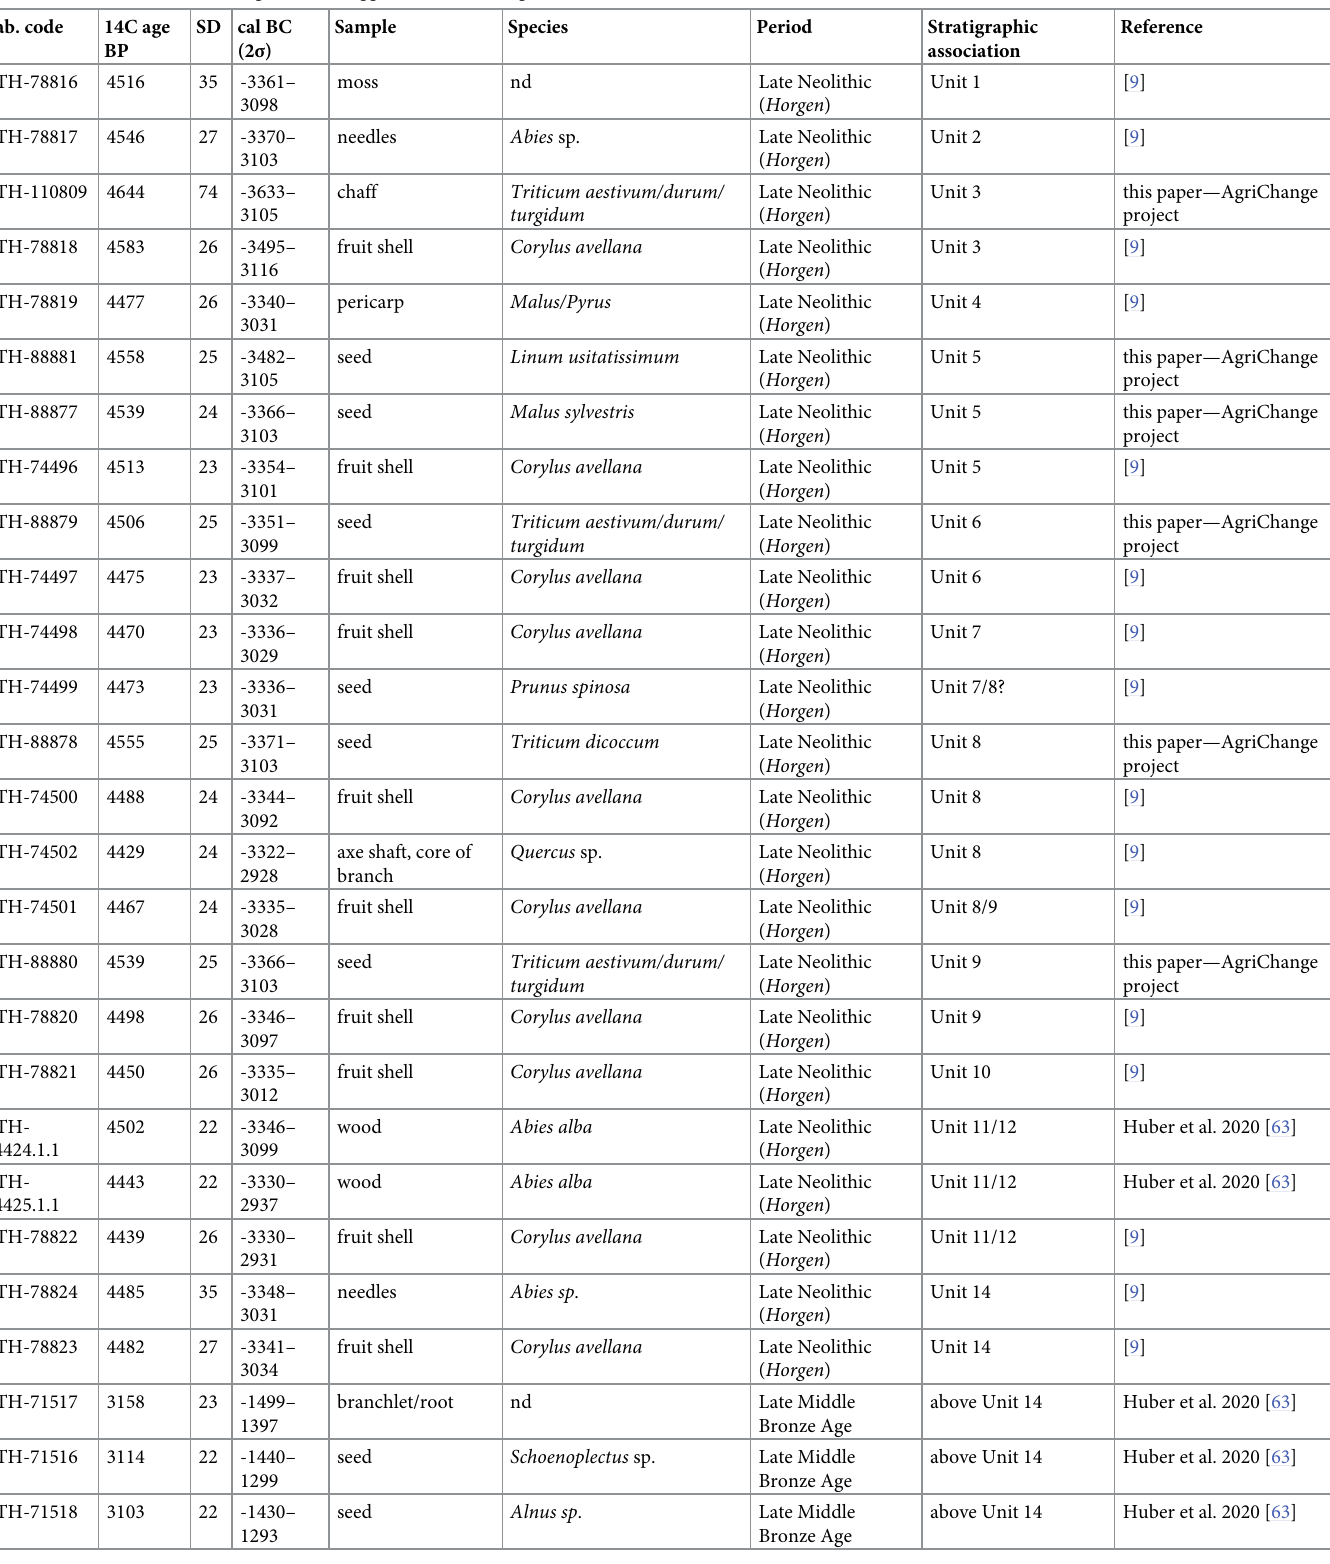
Table 3. AMS radiocarbon datings of waterlogged finds from Zug-Riedmatt (nd = undetermined). Lab.